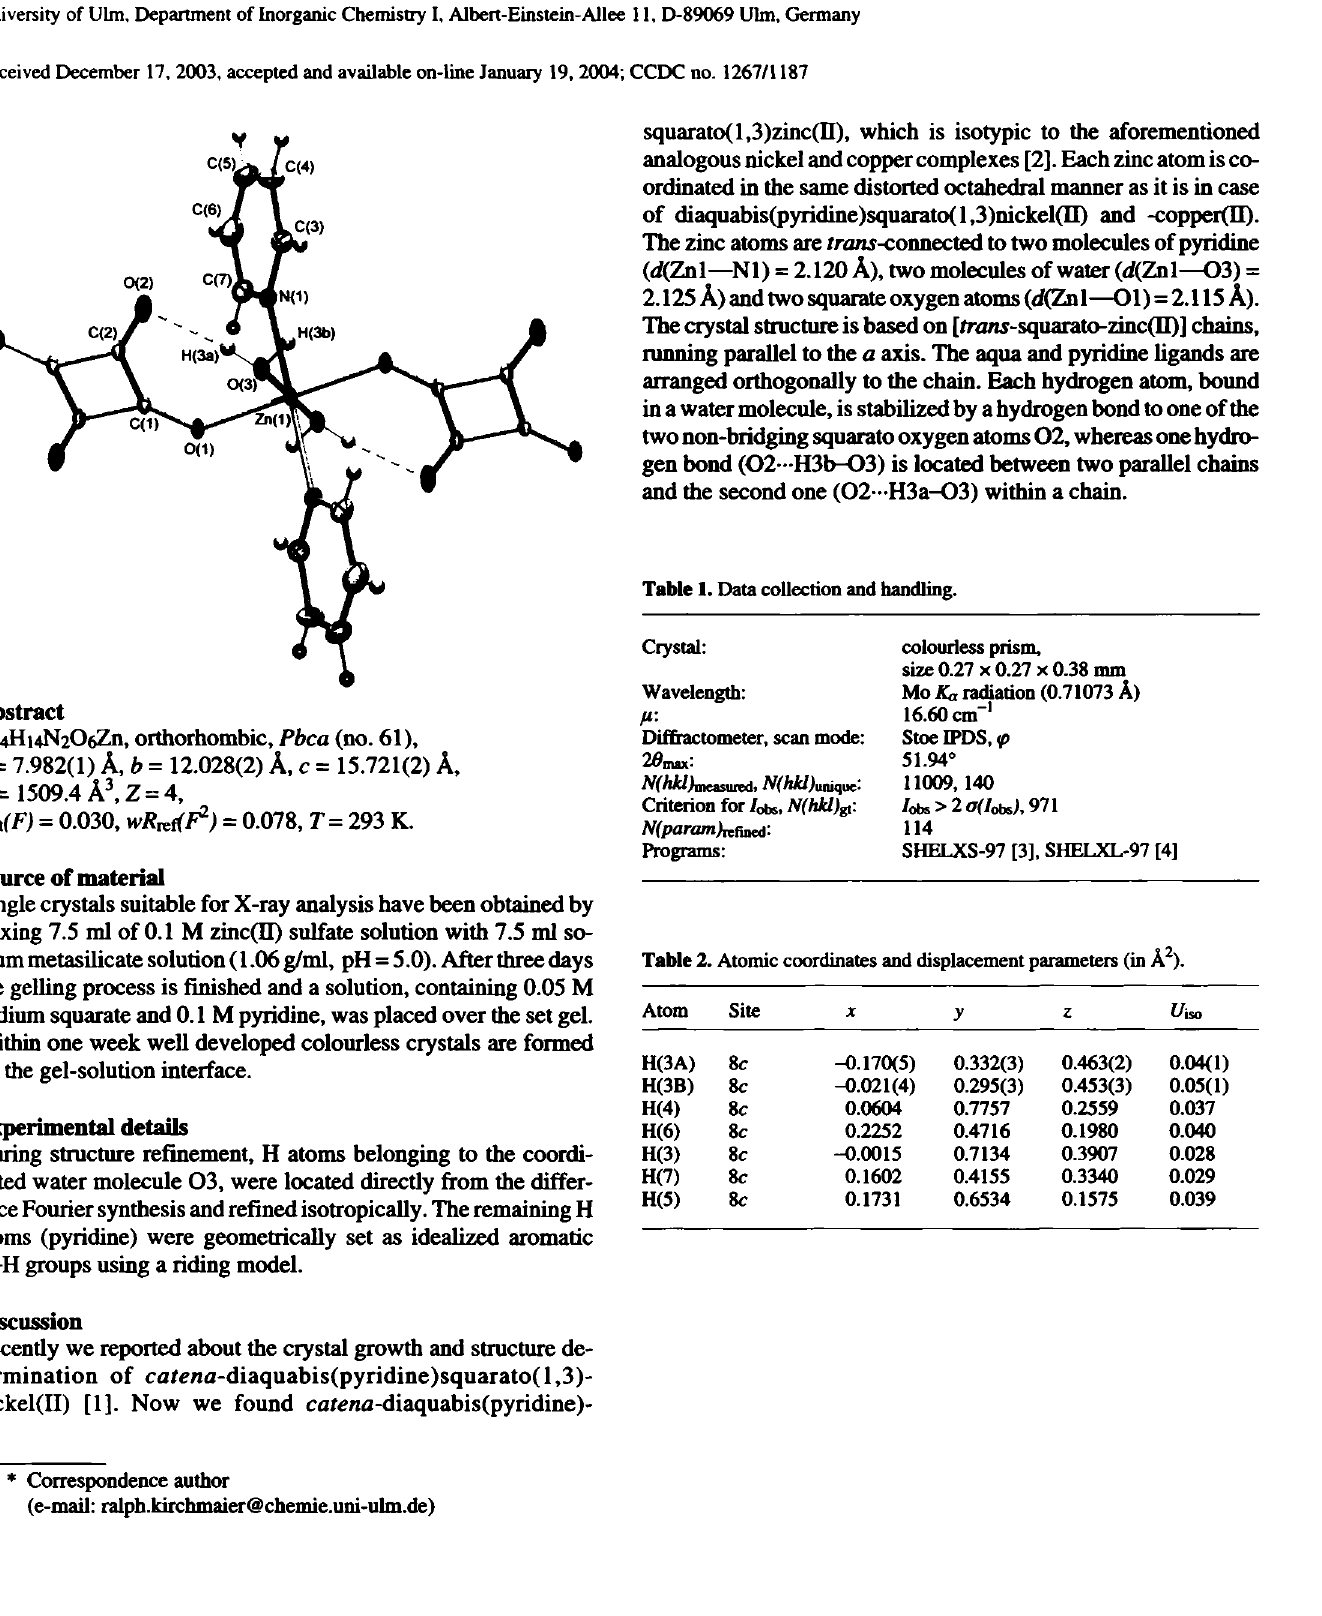
Table 2. Atomic coordinates and displacement parameters (in Â 2